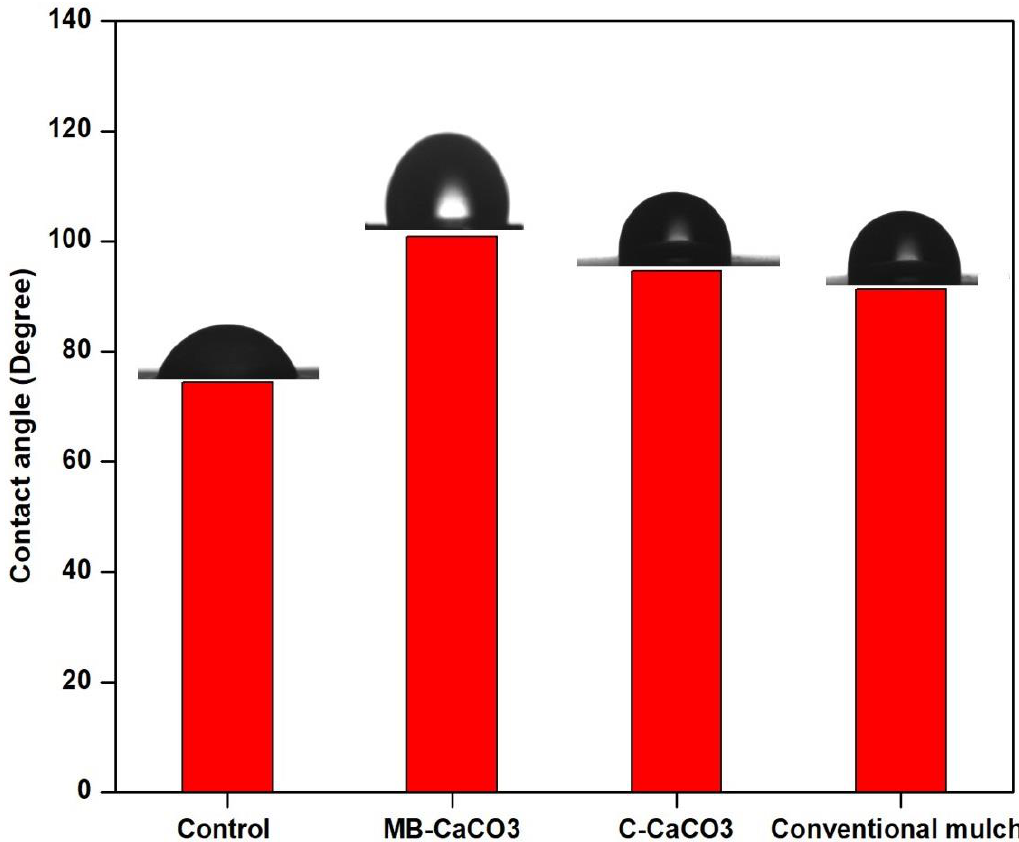
Figure 1. Contact angle of control, MB–CaCO 3 , C–CaCO 3 , and conventional mulch films.